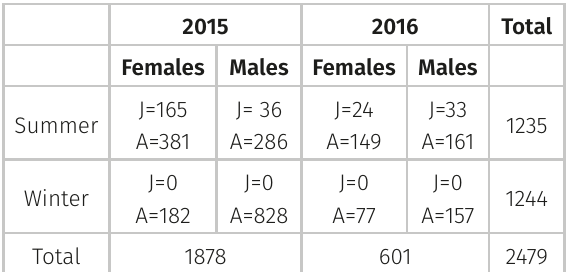
Table I. Total of fleas by year, season, sex and age (A= adult, J= juvenile) in Zaedyus pichiy from Mendoza,